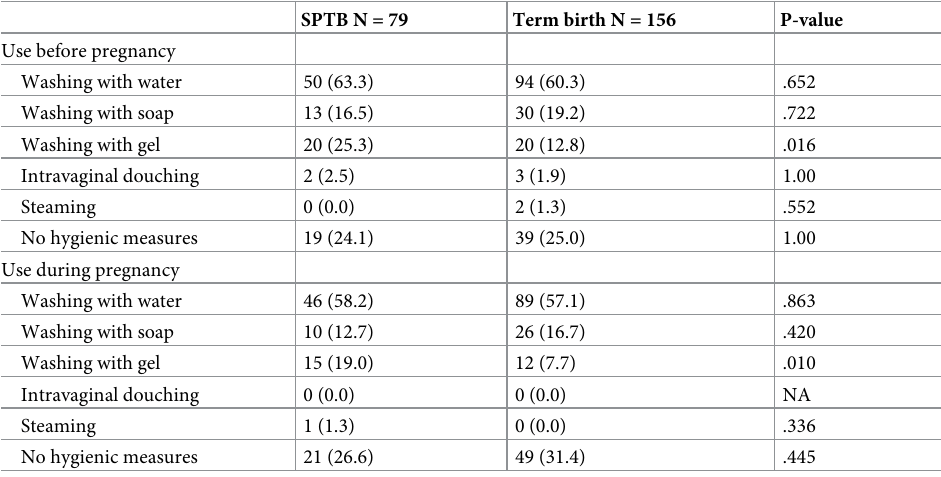
Table 2. Vaginal hygiene practices for cases and